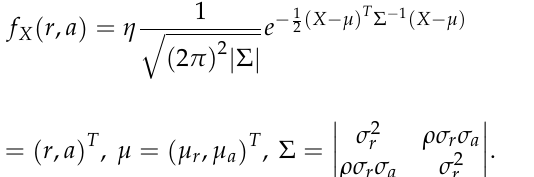
Figure 4. 3D illustration of the initial probability distribution.